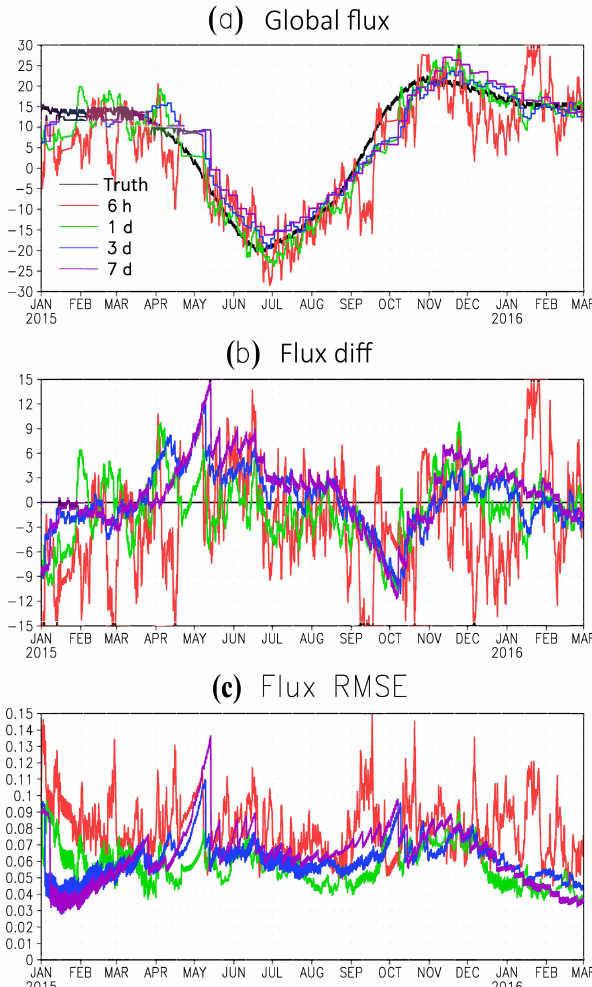
Figure 2. (a) The global total SCF from the nature run (“truth”, black line) and from the estimations of the first set of experiments with different AW. (b) The difference of global total SCF between the estimations from the experiments with different AW and the na- ture run (truth). (c) The global average RMSE of the estimated SCFs from the experiments with different